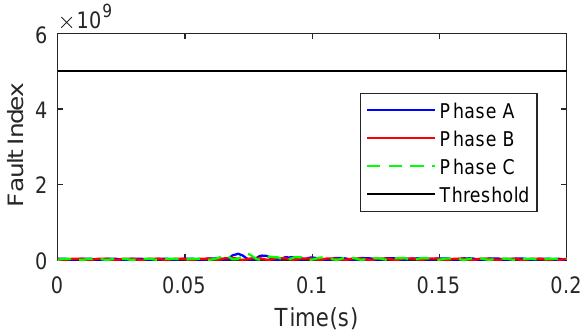
Figure 11. FI at the moments of capacitor switching